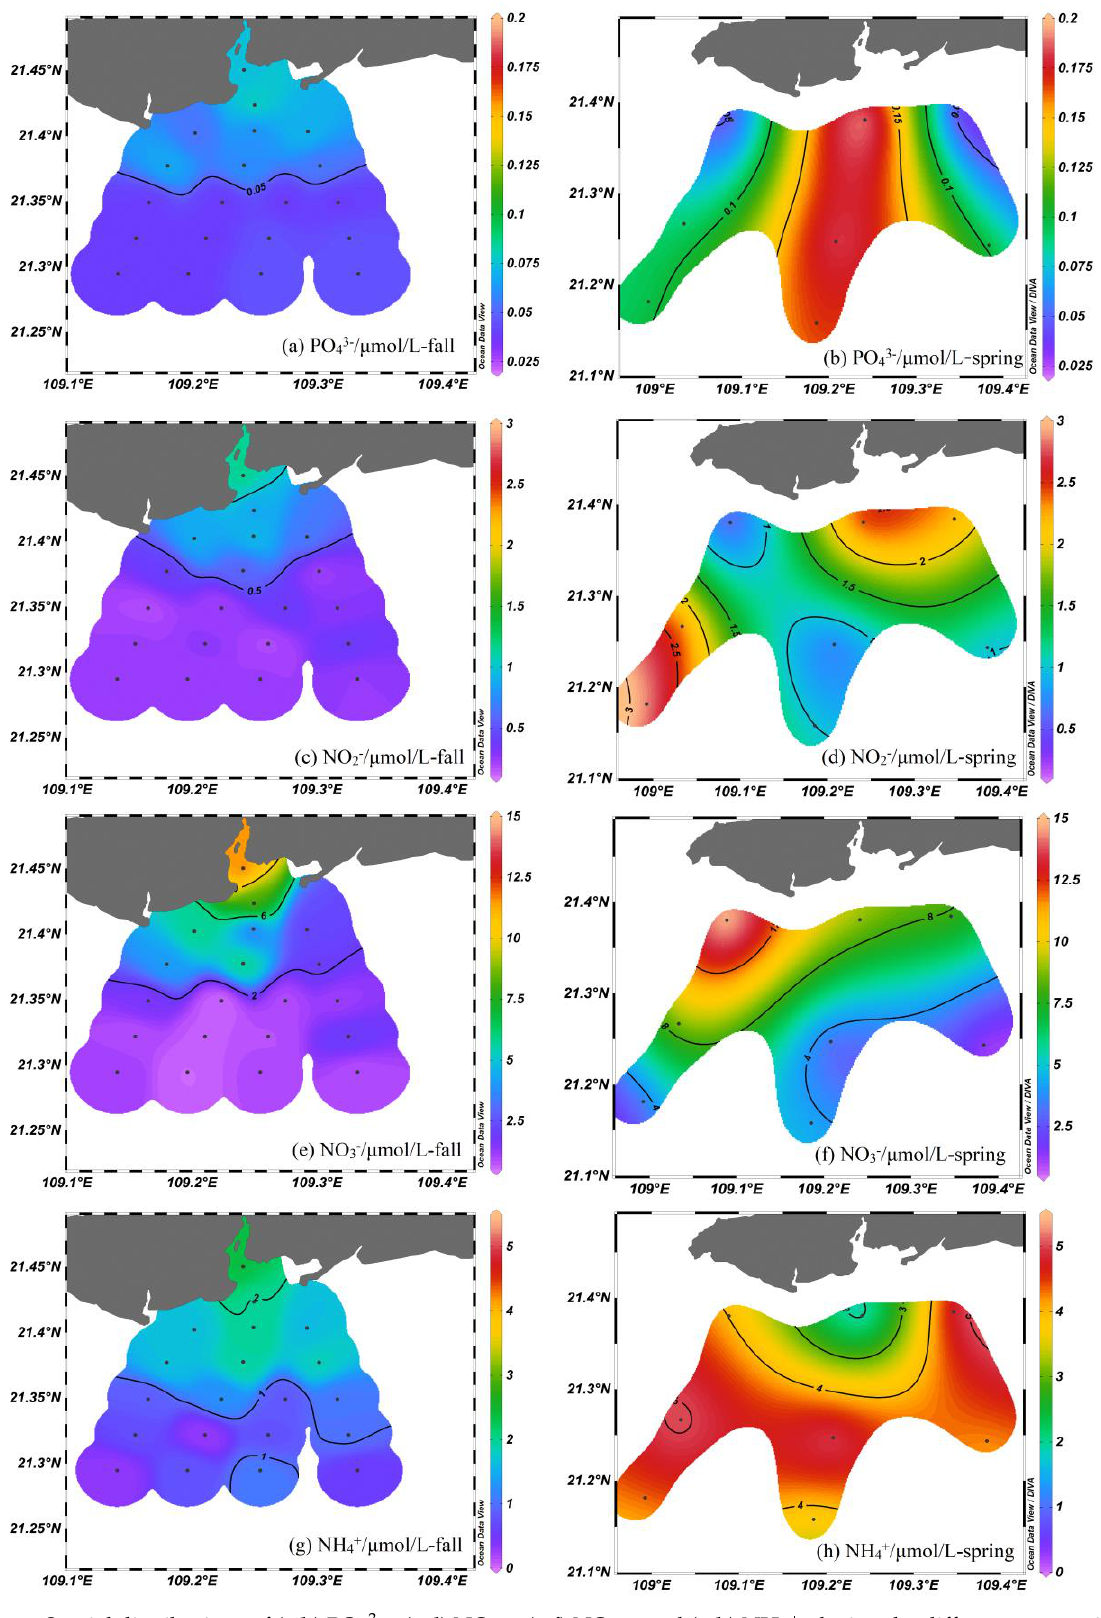
Figure 3. Spatial distributions of ( a , b ) PO 4 3 − , ( c , d ) NO 2 − , ( e , f ) NO 3 − , and ( g , h ) NH 4 + , during the different seasons in the north-eastern Beibu Gulf, China.